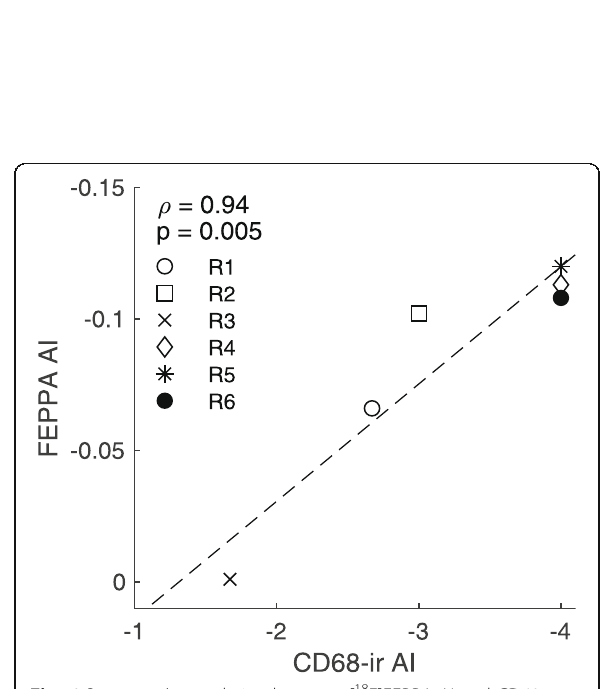
Fig. 6 Spearman ’ s correlation between [ 18 F]FEPPA AI and CD68 immunoreactivity (CD68-ir) AI for each of the six monkeys (Spearman ’ s ρ = 0.94, p = 0.005). AI < 0 indicates increased [ 18 F]FEPPA/CD68-ir in the ipsilateral